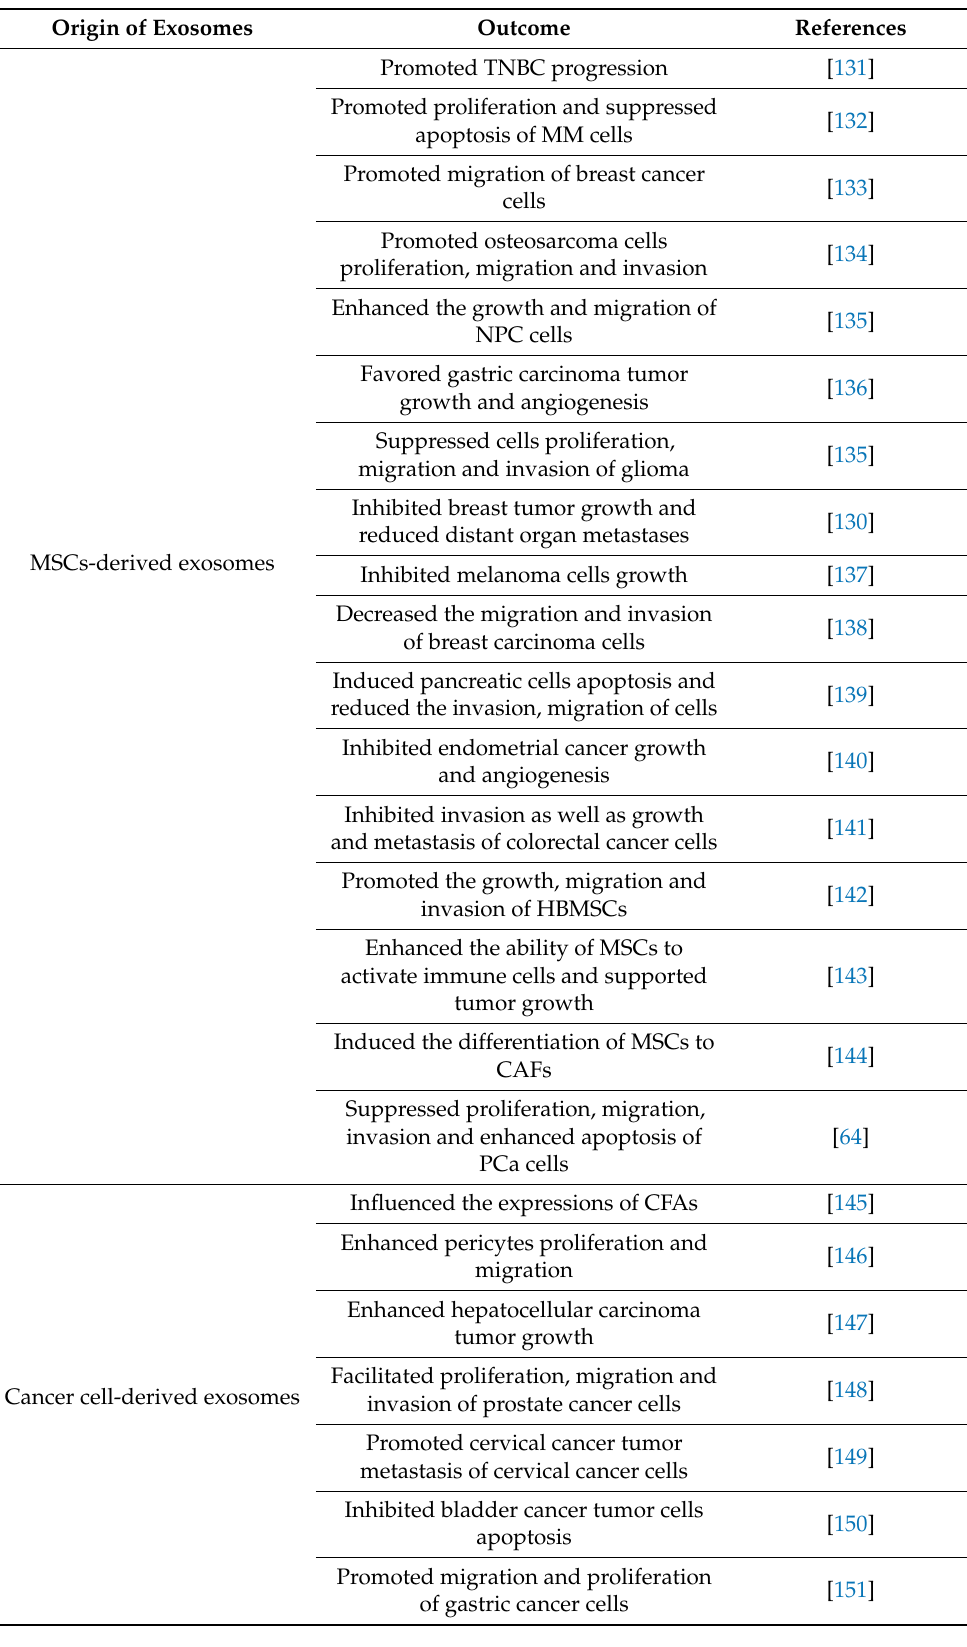
Table 4. The roles of exosomes from different sources in